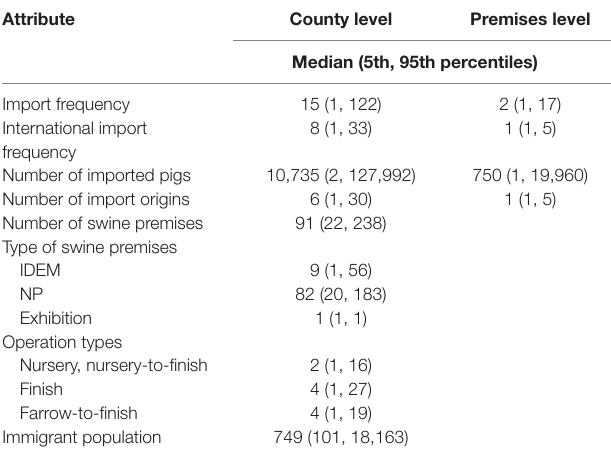
TaBle 1 | summary of county- and premises-level attributes used for the selection of the most likely classical swine fever outbreak scenarios in indiana, United